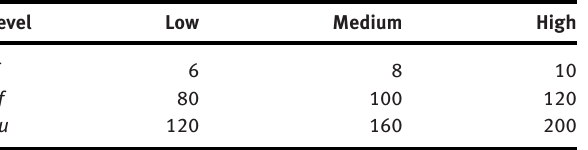
Table 3: Design of experiments matrix with the observed